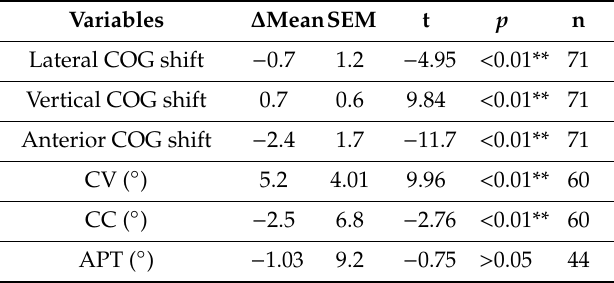
Table 3. Paired samples t -test of COG and postural angles shift with mean di ff erence. Variables ∆ MeanSEM t p n